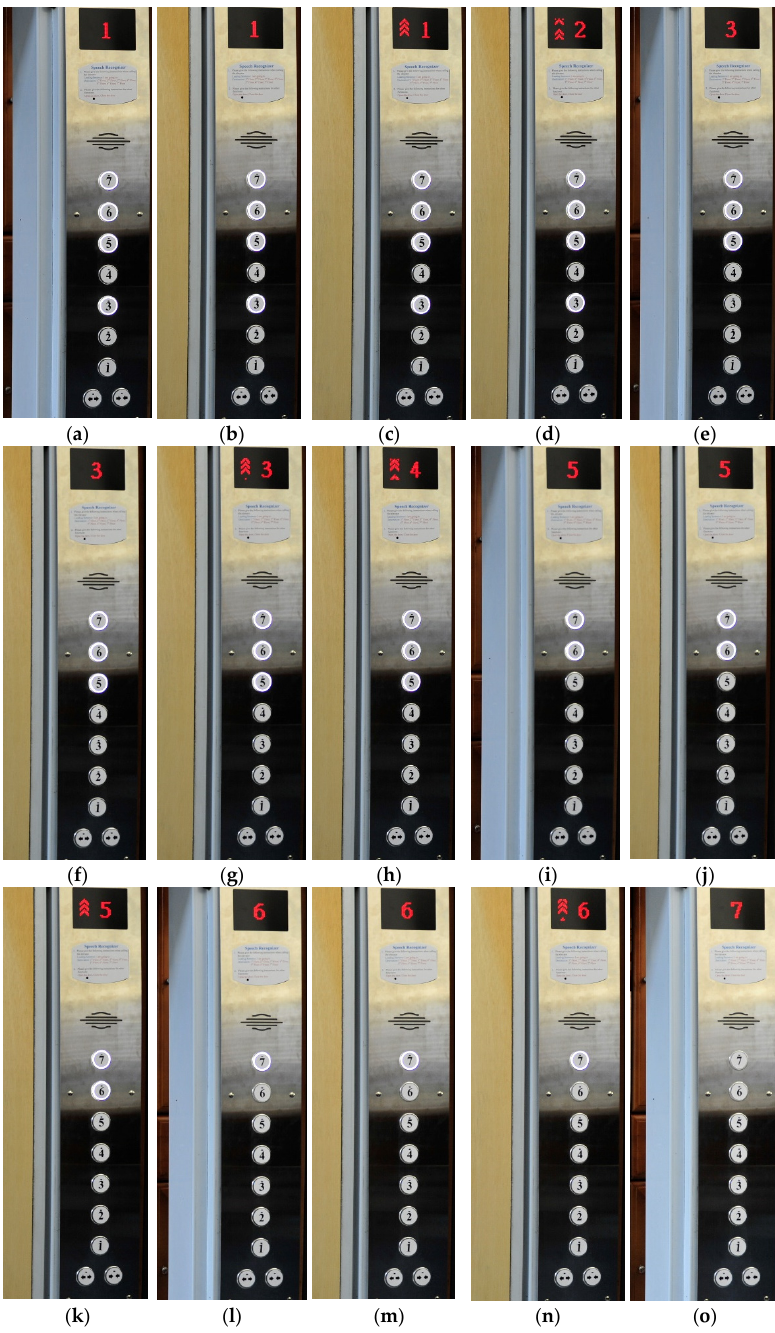
Figure A7. The system verification process of the contact-free epidemic prevention elevator. ( a ) The elevator stops at 1F (the elevator door is open), and the buttons 3F and 5F–7F are activated (the button lights are on); ( b ) the elevator door is closed; ( c ) the elevator starts to ascend; ( d ) the elevator continues to ascend through 2F; ( e ) the elevator stops at 3F, the elevator door opens, and the button light of 3F goes out; ( f ) the elevator door is closed; ( g ) the elevator starts to ascend; ( h ) the elevator passes through 4F and continues to ascend; ( i ) the elevator stops at 5F, the elevator door opens, and the button light of 5F goes out; ( j ) the elevator door closes; ( k ) the elevator starts to ascend; ( l ) the elevator stops at 6F, the elevator door opens, and the button light of 6F goes out; ( m ) the elevator door is closed; ( n ) the elevator starts to ascend; ( o ) the elevator stops at 7F, the elevator door opens, and the button light of 7F goes